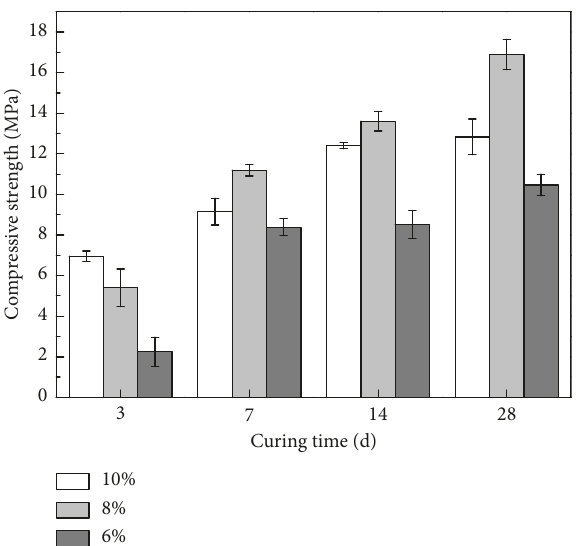
Figure 4: XRD patterns of CNSCMs with different SS contents with a curing time of